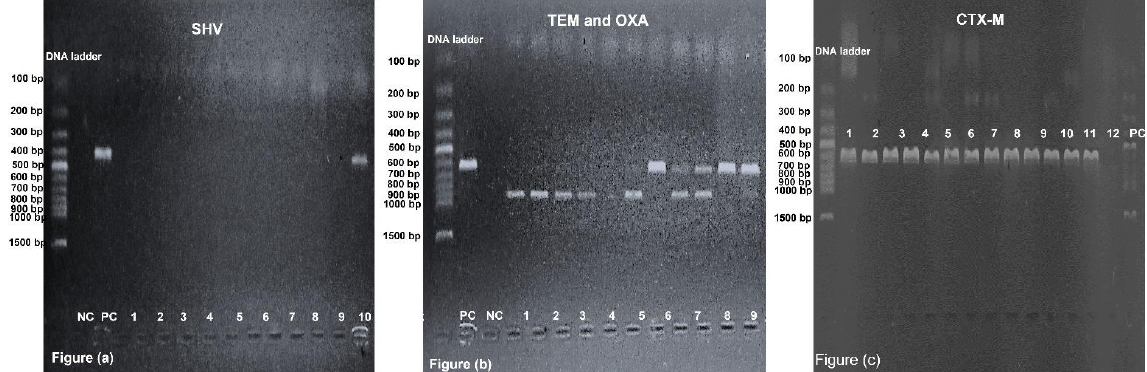
Figure 1. Visualization of DNA bands by gel electrophoresis. (a) Lane-NC and PC stand for negative and positive control, respectively. Lane-12 is showing band of 392 bp, which is related to bla SHV gene, and lane-1, -2, -3, -4, -5, -6, -7, -8, -9, -10 and -11 are negative for bla SHV gene. (b) Lane-NC and PC stand for negative and positive control, respectively. Lane-1, -2, -3, -4 and -6 are showing bands of 860 bp, which is related to bla TEM gene. Lane-7 and -10 are showing bands of 619 bp, which is related to bla OXA gene. Lane-8, -9 and -11 are showing both 860 bp and 619 bp bands, which are related to bla TEM and bla OXA , respectively. Lane-5 has no band. (c) Lane-NC and PC stand for negative and positive control, respectively. Lane-1 to -12 are showing bands of 593 bp, which is related to bla CTX -M gene.